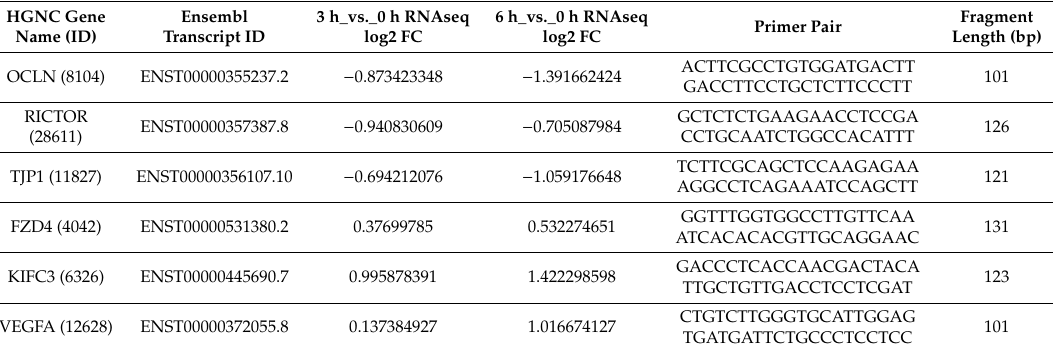
Table 1. Transcripts selected for RNA-seq data validation by quantitative real-time polymerase chain reaction (qRT-PCR). Regarding the data discussed in the text, 3 down-expressed and 3 up-regulated coding genes were chosen for data validation. For each gene, the HUGO (Human Genome Organization) Gene Nomenclature Committee (HGNC) name, the Ensembl-specific transcript ID, the log 2 fold change detected by RNAseq at both 3 and 6 h after N -retinylidene- N -retinylethanolamine (A2E) treatment, the primer pair and the specific length of the amplicon are reported. FC: fold change; bp: base-pairs.